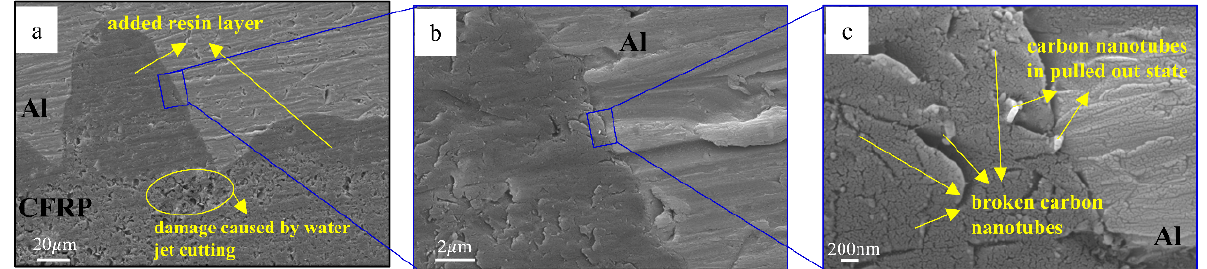
Figure 7. Interlayer carbon nanotube metallographic diagram at different magnification of laminate C.